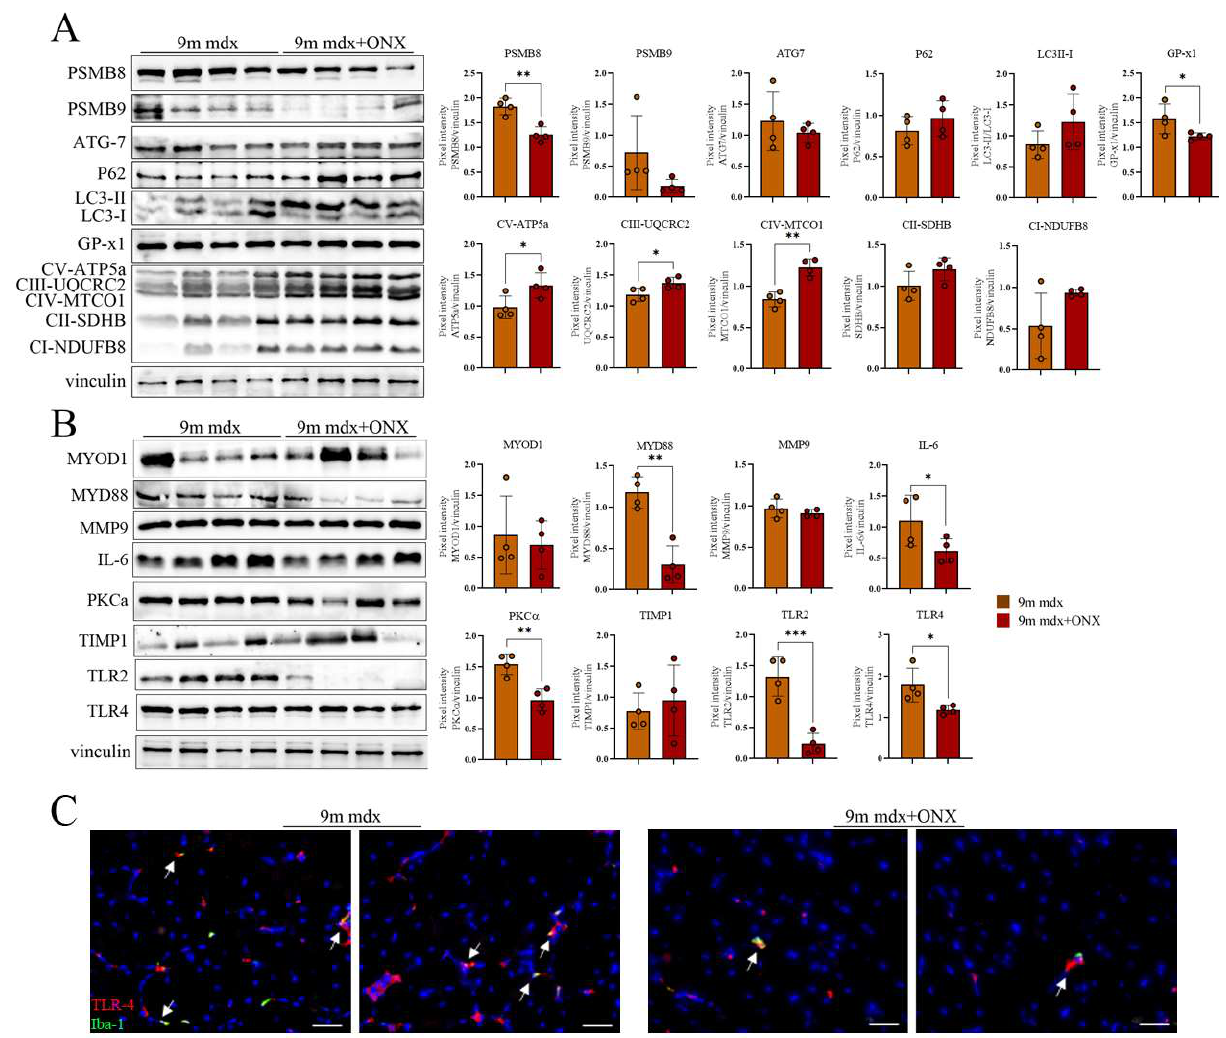
Figure 4. Anti-inflammatory and fibrotic effects of ONX-0194 on skeletal muscle of 9m mdx mice. Cropped images of representative WB showing the expression of proteins involved in ( A ) immuno- proteasome, autophagy, oxidative phosphorylation, and ( B ) fibrosis and inflammation in skeletal muscles from 9m mdx mice treated with ONX-0914 versus untreated mice. Densitometric analyses of protein expression is shown as a ratio on vinculin. ( C ) Fluorescent staining of TLR-4 (in red) and Iba-1 (in green) while nuclei are in DAPI (blu) (scale bar: 50 μm) in TA of 9m mdx and 9m mdx+ONX. Macrophages expressing TLR-4 are evidenced by white arrows. Data are expressed as means ± SD of n = 3 independent experiments with n = 4 mice for animal groups (* p < 0.05, ** p < 0.01, *** p < 0.001, with unpaired t -test).